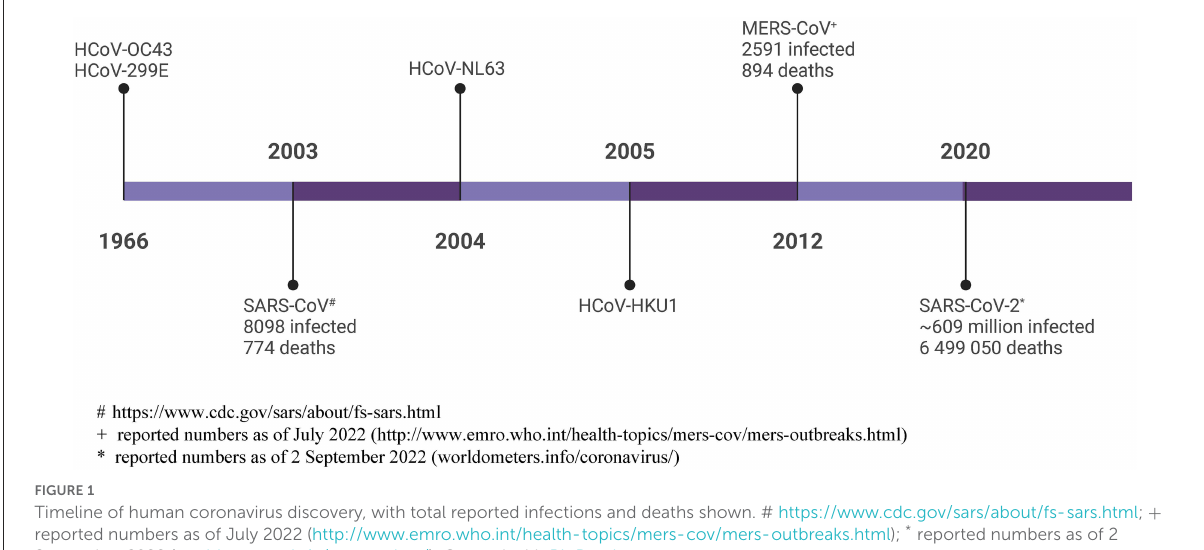
FIGURE1 Timeline of human coronavirus discovery, with total reported infections and deaths shown. # https://www.cdc.gov/sars/about/fs-sars.html; + reported numbers as of July 2022 (http://www.emro.who.int/health-topics/mers-cov/mers-outbreaks.html); * reported numbers as of 2 September 2022 (worldometers.info/coronavirus/). Created with